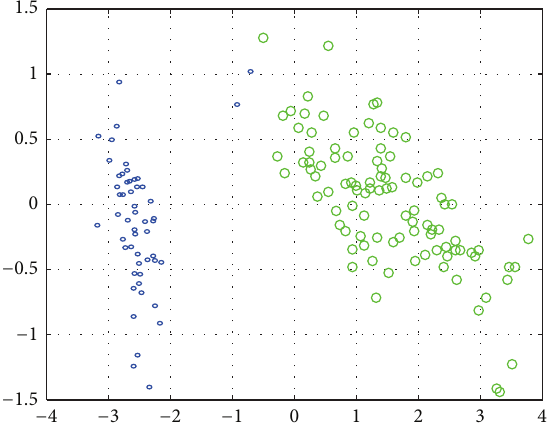
Figure 7: Clustering results obtained by standard K -means. Table 3: Number of misclassification and accuracy of various discriminant methods under Iris dataset.